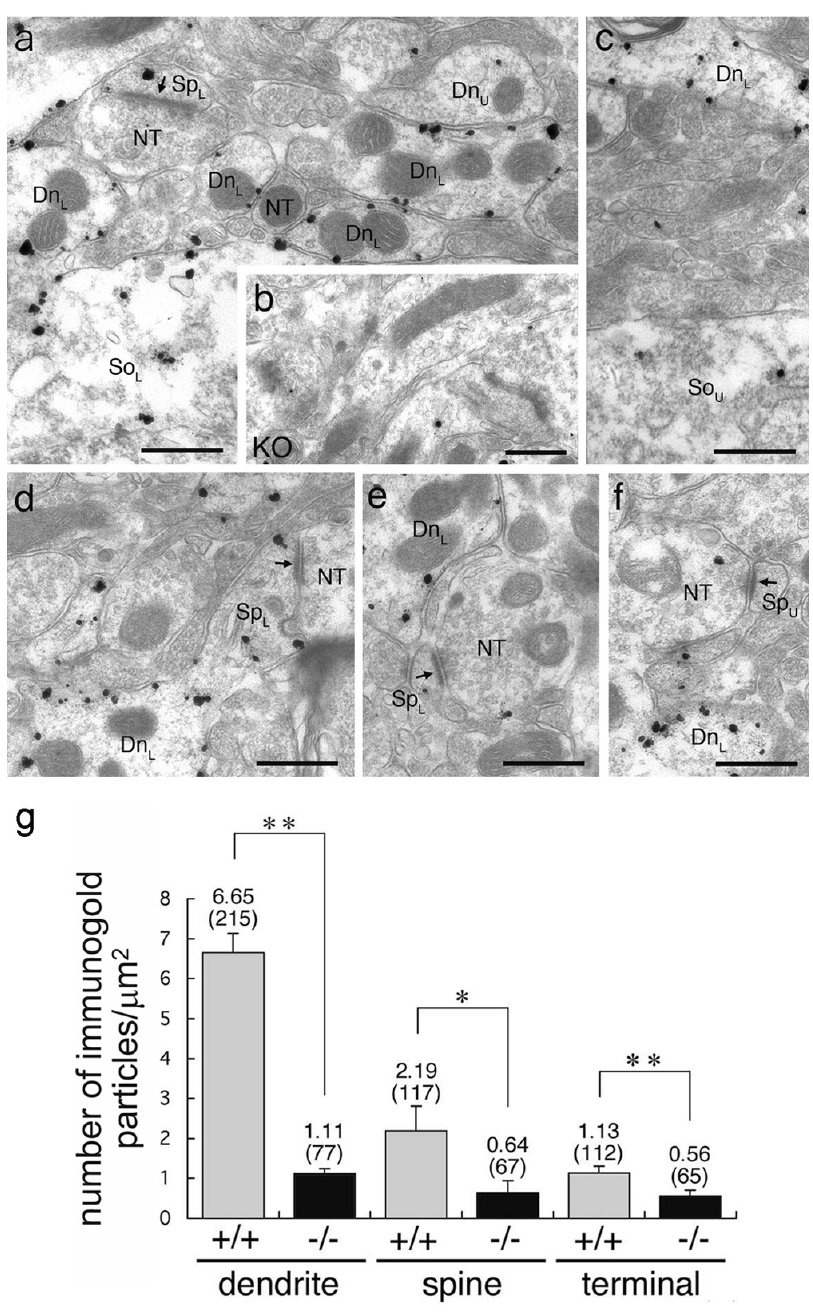
FIGURE 2. Electron micrographs of mouse striatum with A 2A receptors labeled with silver- enhanced immunogold. (a,c,d) Predominant labeling in some somata (So), dendrites (Dn), and spines (Sp). Strongly labeled elements are indicated by So L , Dn L , and Sp L , while unlabeled or weekly labeled elements are indicated by So U , Dn U , and Sp U . (b) Negative control showing virtual lack of immunogold labeling for A 2A receptors in the striatum of A 2A receptor knockout mice. (e,f) Less- predominant labeling in nerve terminals (NT) from asymmetric synapses (arrows) with unlabeled spines (f) and more rarely with labeled spines (e). (g) Quantitative analysis of immunolabeling density for A 2A receptors in the striatum of wild-type (+/+) and A 2A receptor knockout mice (–/–); labeling of terminals is only counted for those forming asymmetric synapses with spines; results are indicated as mean ± SEM; * and **: p < 0.05 and p < 0.01, respectively. Scale bars: 500